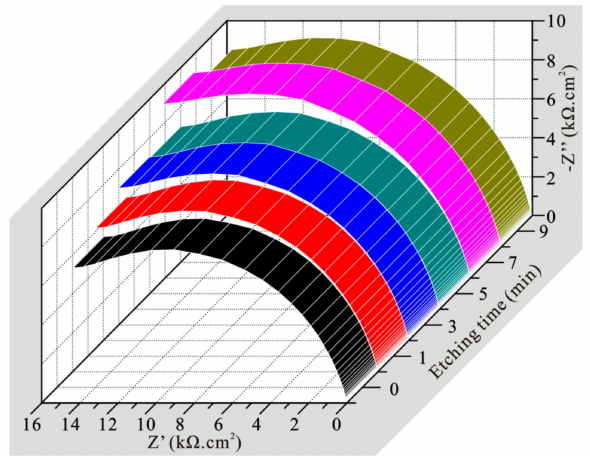
Figure 12. Electrochemical impedance spectra of modified 7075 aluminum alloys with various etching